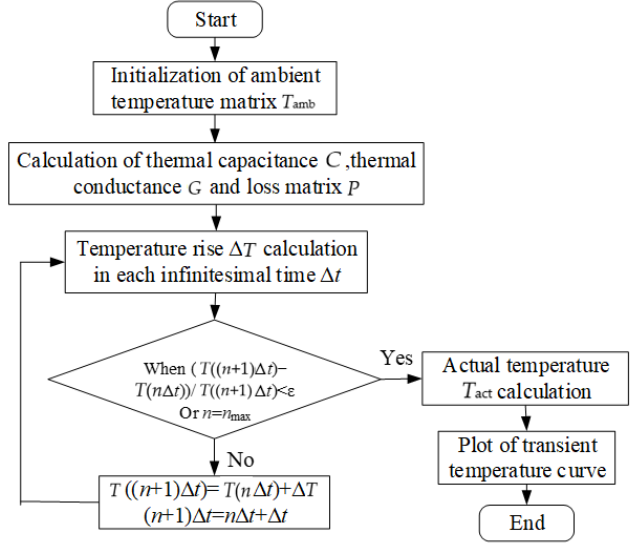
Figure 6. Flow chart of transient temperature